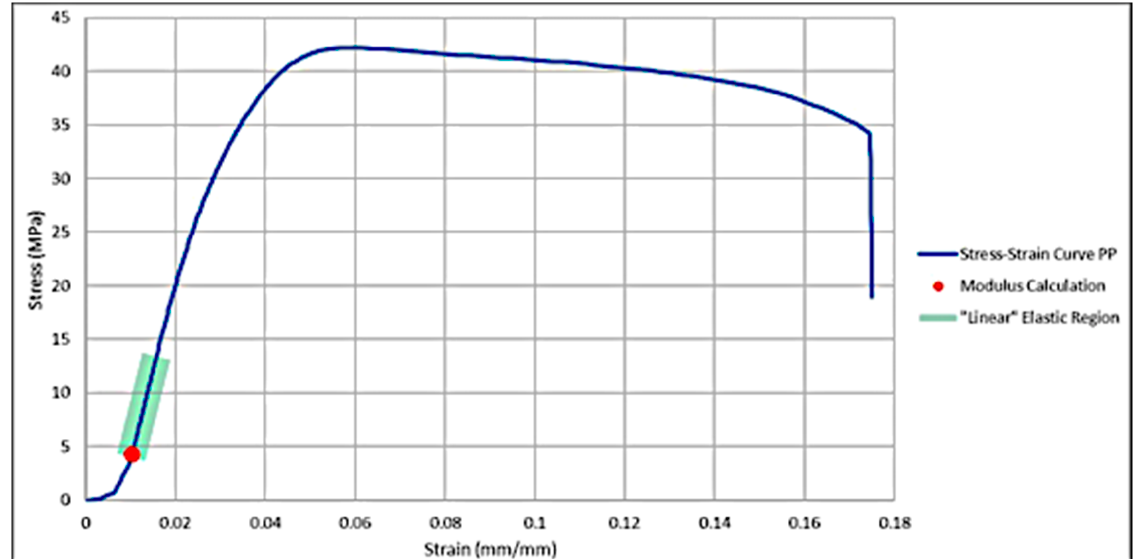
Figure 2. The stress–strain curve for a neat LLDPE sample subjected to tensile testing.